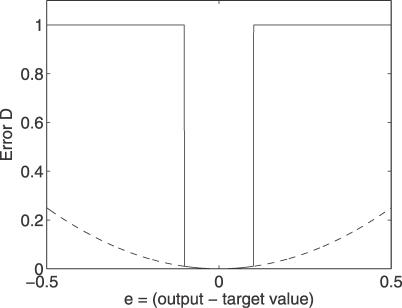
Network Fitness Error FunctionThe response of the network to a given input vector x is y = w · x. Given a desired (target) output d, the solid curve shows how the fitness penalty D for an incorrect response increases sharply (to unity) if the magnitude of the difference e = y − d is greater than 0.1 (i.e., if e
2 > 0.01). For comparison, the quadratic error function e
2 = (y − d)2, which is minimised during learning, is shown as a dashed curve. The range of e-values shown are typical for the simulations reported here. See Methods section for details.